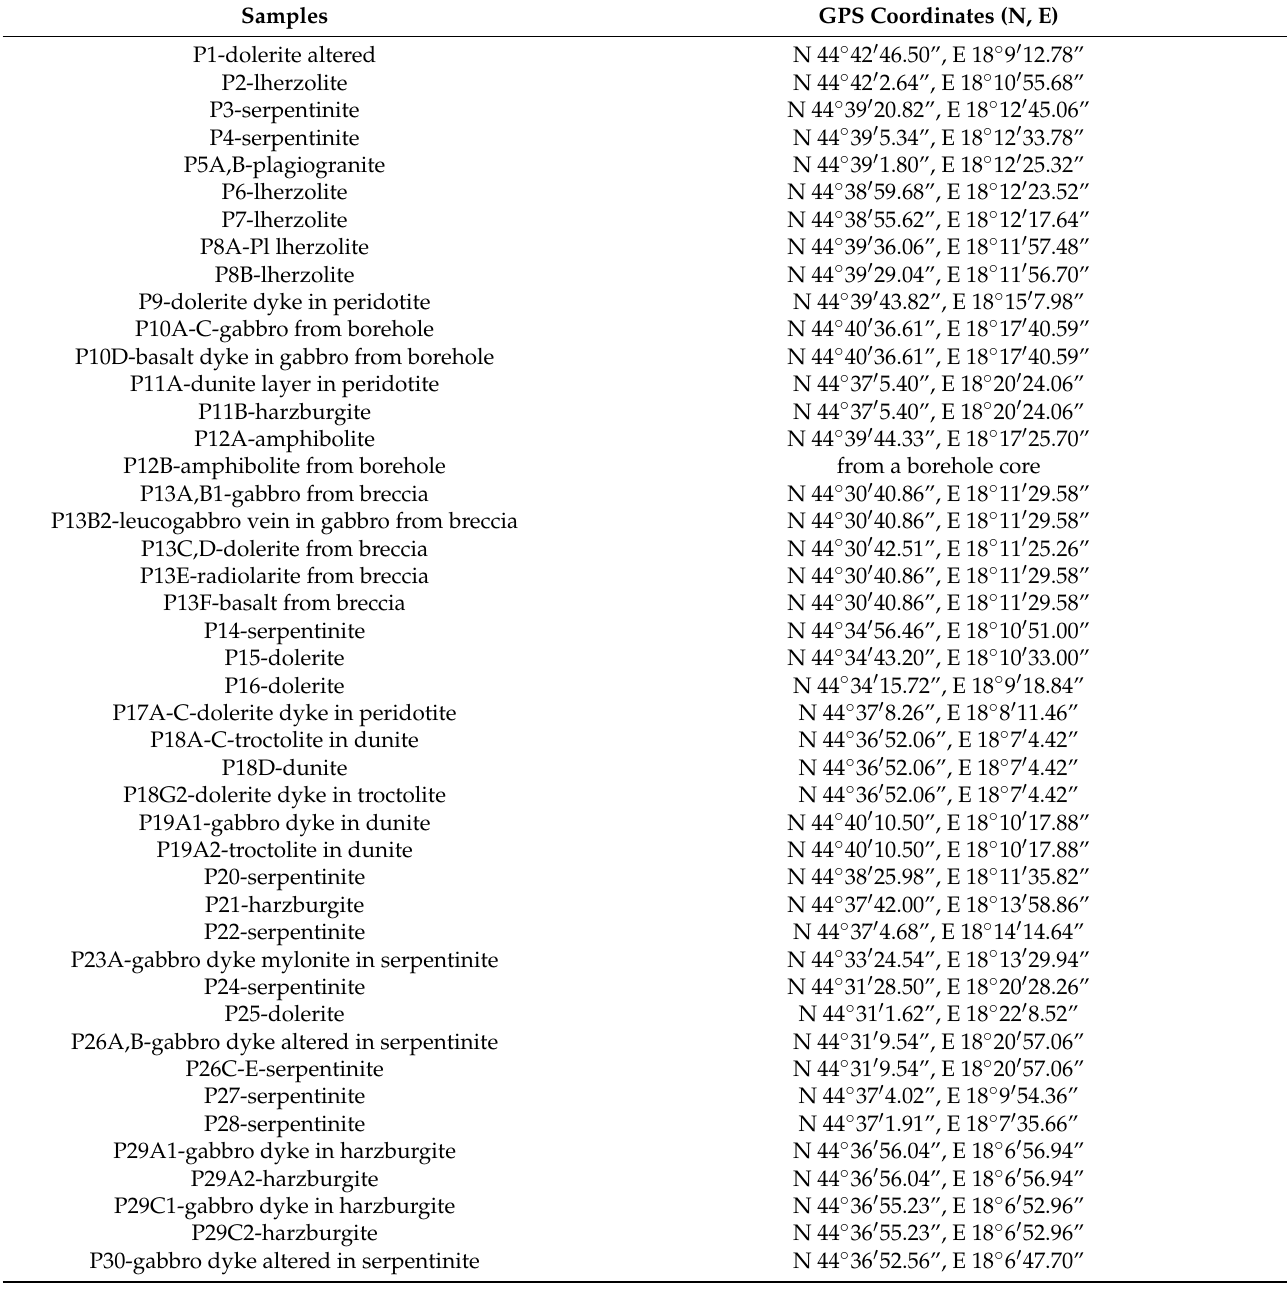
Table 1. GPS locations of investigated samples (22 ultramafics, 33 mafics, 1